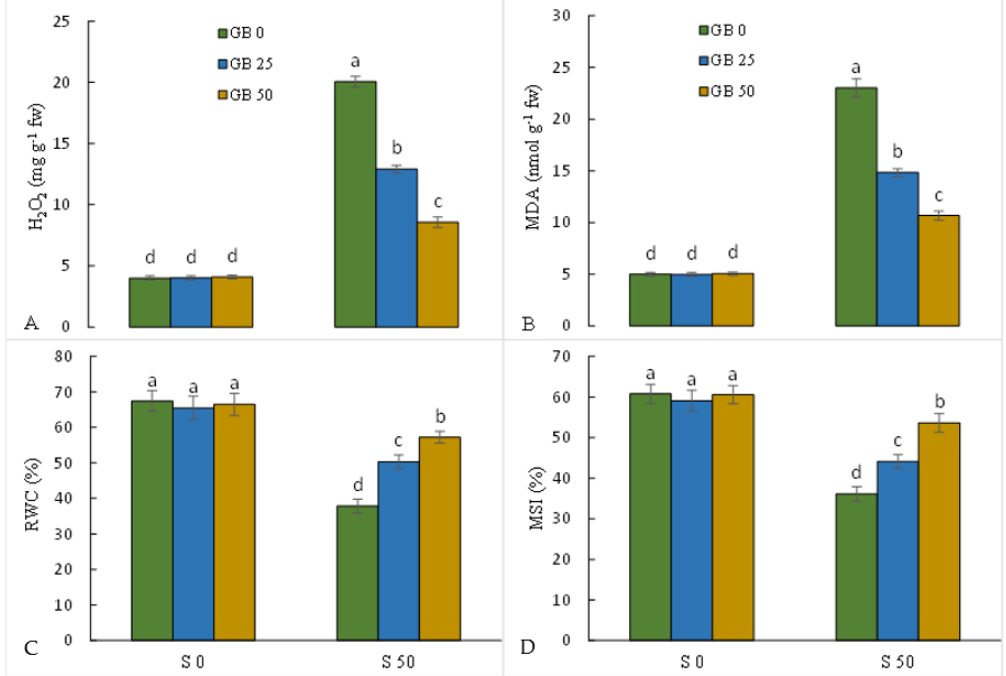
Figure 3. Effect of glycine betaine (GB, 0 and 50 mM) on the content of hydrogen peroxide (H 2 O 2 , ( A )) and malondialdehyde (MDA, ( B )), relative water content (RWC, ( C )), and membrane stability index (MSI, ( D )) of stevia leaves under NaCl (0, 25, and 50 mM) treatment. Values (means ± SD, n = 6) followed by the same letter are not significantly different ( p < 0.05; Duncan test). When 50 mM NaCl was added to the MS medium, the activities of SOD, CAT, GR, and POD enzymes were raised by 52.2, 42.8, 42.8, and 40.8%, respectively, in stevia leaves compared to plants without NaCl. However, with the addition of GB to the culture me- dium containing NaCl, the activity of the above-mentioned antioxidant enzymes showed a greater increase, and the highest increase effect was found under the treatment of 50 mM GB (Figure 4A – D).